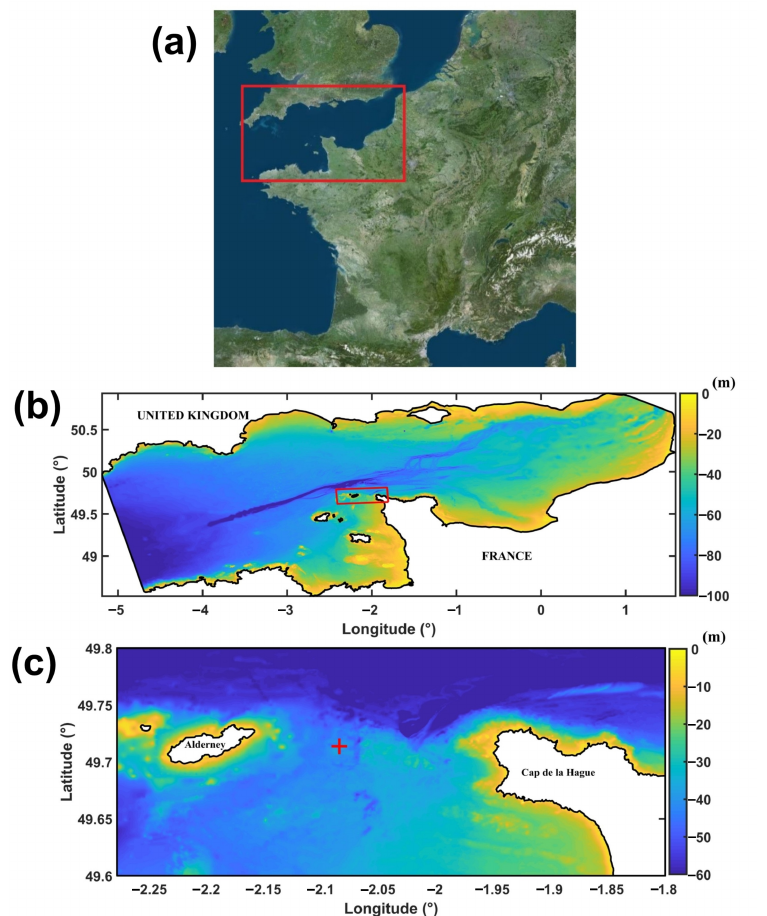
Figure 2. ( a ) Location of the study zone. ( b ) English Channel computational domain and bathymetry. ( c ) The red cross represents the location of the array.